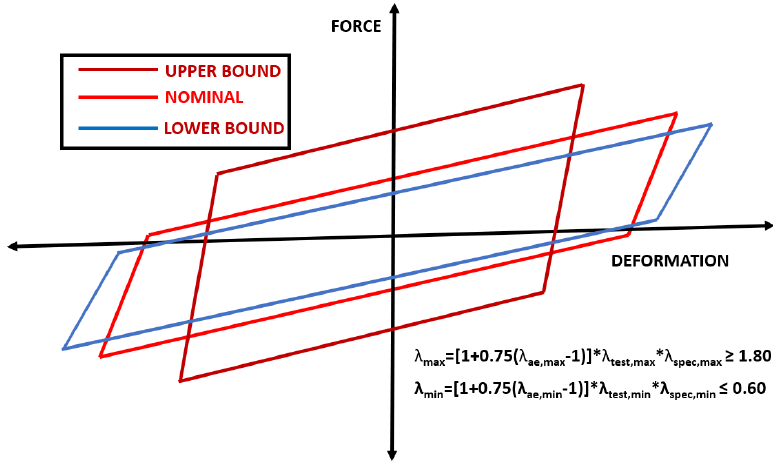
Figure 24. Bounding analysis for isolation systems in ASCE/SEI 7-16 [70].